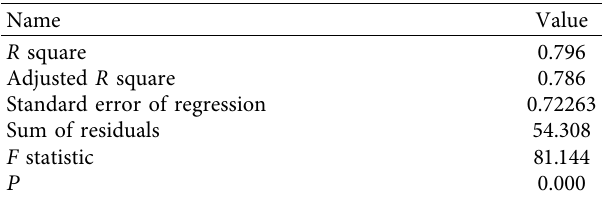
Table 15: Statistics of quadratic models (mean velocity variation in a certain window width).